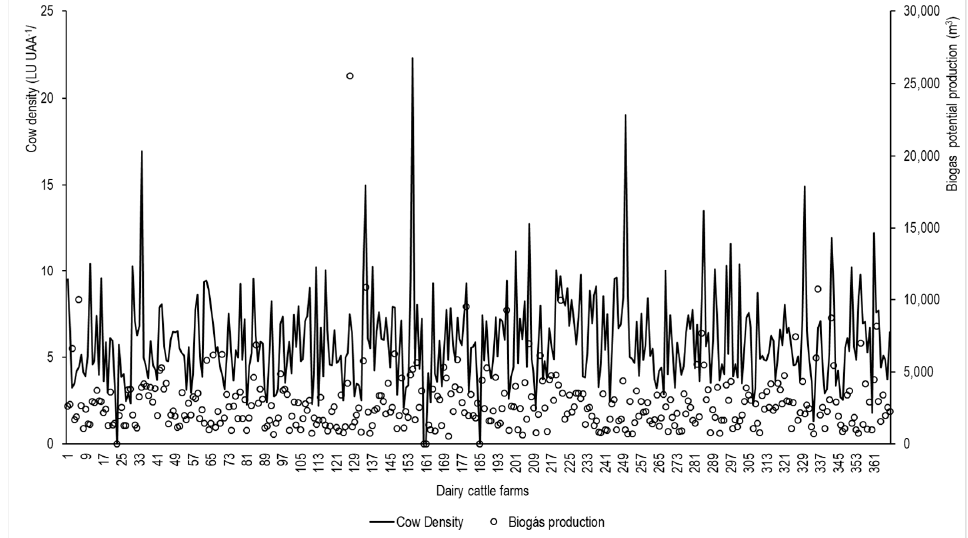
Figure 2. Number of cows and biogas potential production (m 3 ) per dairy cattle farm.